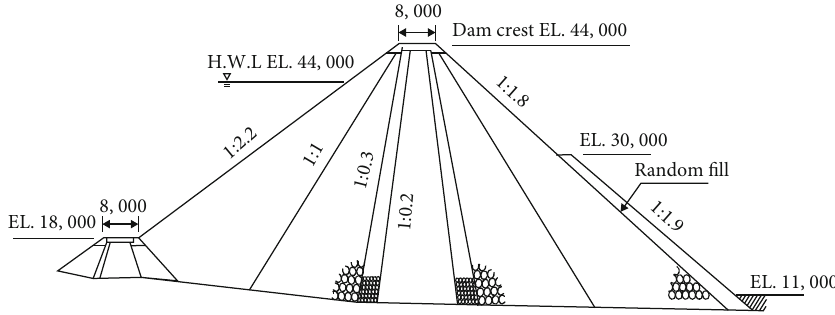
Figure 2: Cross-sectional plan (unit: mm).